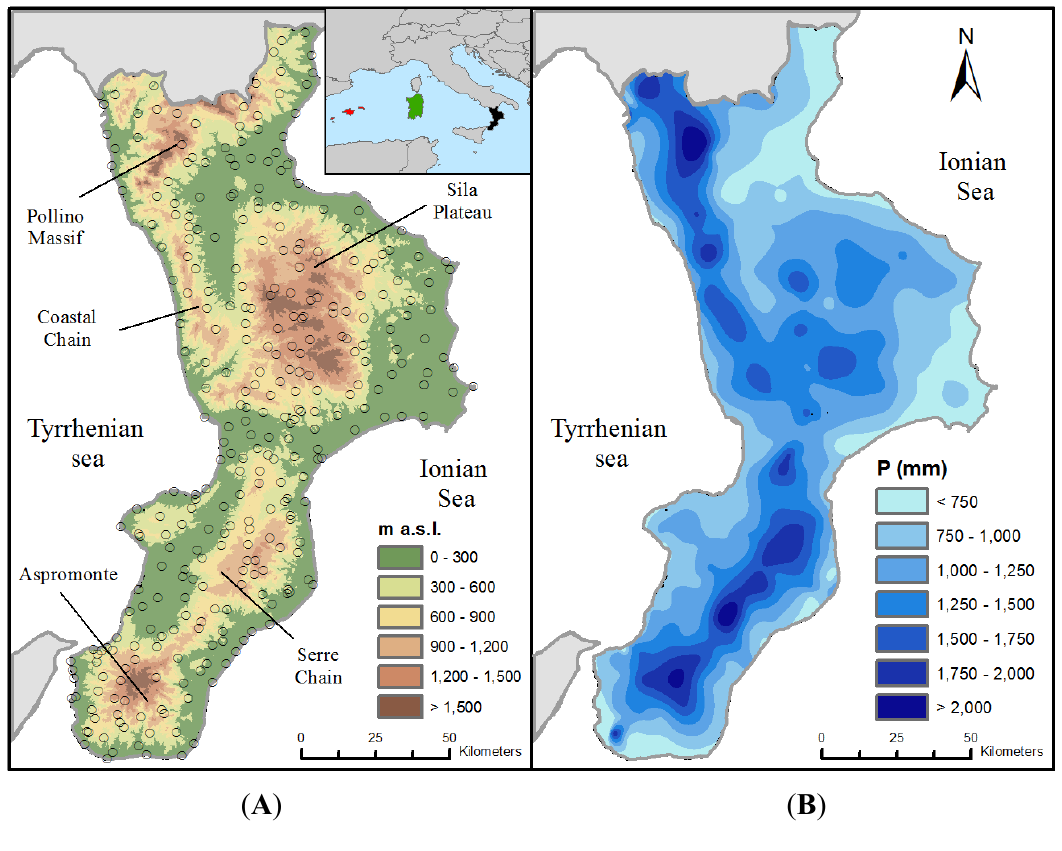
Figure 1. ( A ): digital elevation model of Calabria and rainfall gauges (circles); ( B ): regional distribution of the average annual rainfall ( P ). Small box: localization of the Calabria region (in black) in the Mediterranean Basin with the identification of the Sardinia region (in green) and of the Balearic Islands (in